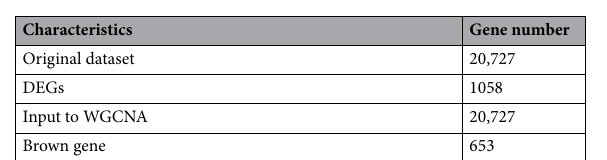
Table 1. The number of genes in each phase of the analysis. DEGs, differentially expressed genes; WGCNA, weighted gene coexpression network